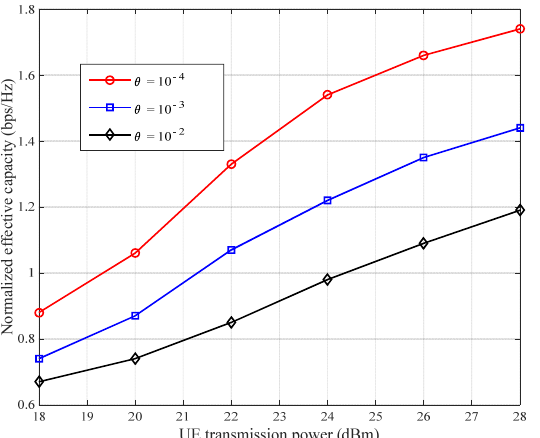
θ and normalized effective network capacity.